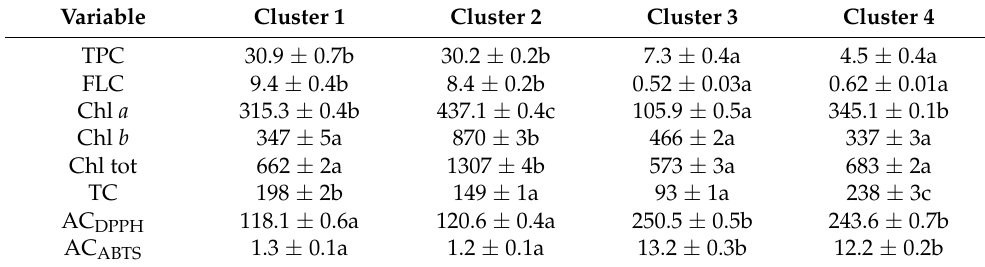
Table 4. ANOVA results of hierarchical cluster analysis (mean ± SD).